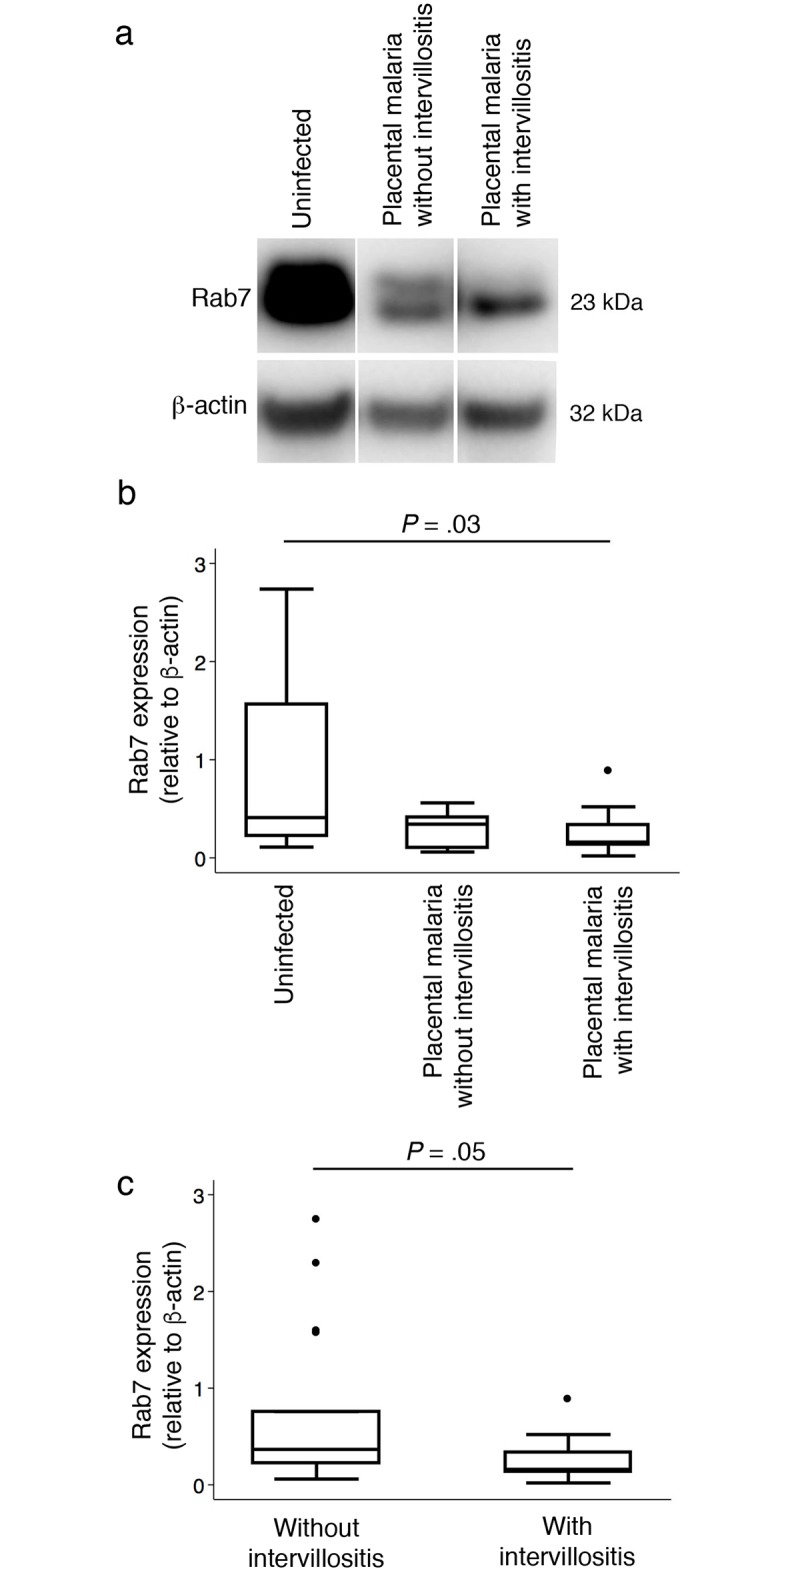
Expression of Rab7 in placental homogenates.(A) Representative western blot of uninfected, placental malaria without intervillositis and placental malaria with intervillositis. Rab7 expression was compared (B) between uninfected placentas (n = 17) and infected placentas without (n = 7) or with (n = 14) intervillositis and (C) between placentas without (n = 24) and with (n = 14) intervillositis. Bars represent median, 25th and 75th percentiles, the whiskers are 5th and 95th percentiles and the dots are outliers.